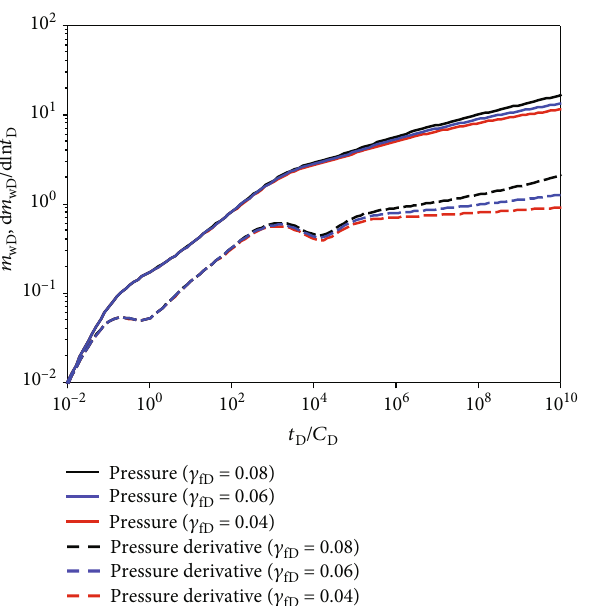
Figure 7: E ff ect of the storability ratio of the fracture, ω , on fD curves.